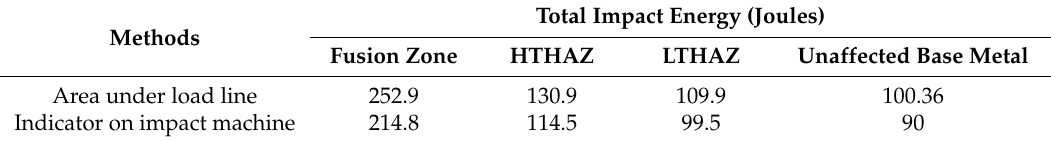
Table 3. Impact Table 3. Impact energy.